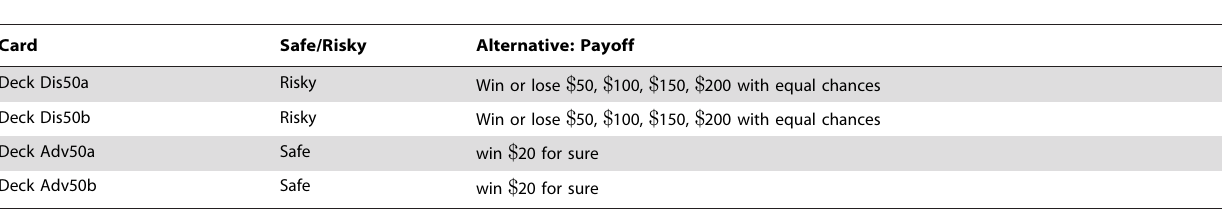
Table 2. The schedule of rewards and penalties in the four decks of cards of the EGT.